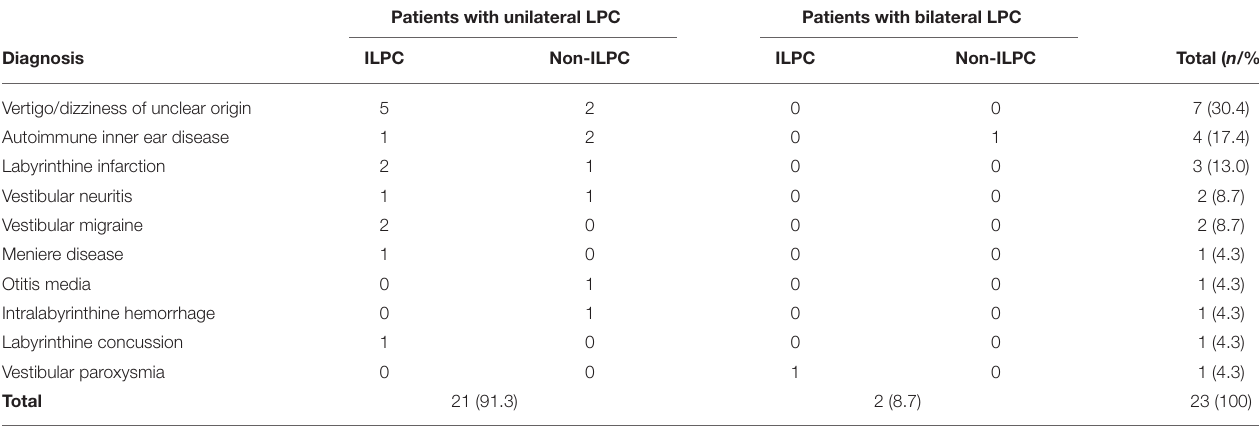
TABLE 1 | Underlying diagnoses in patients with LPC on vHIT. Patients with unilateral LPC Patients with bilateral